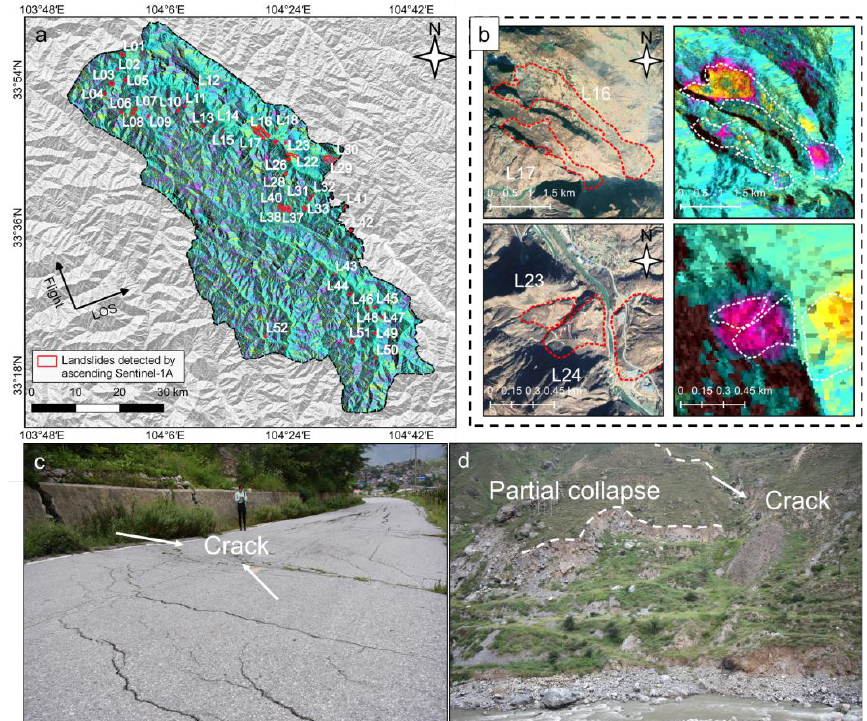
Figure 4. Stacking-InSAR landslide detection results based on ascending data: ( a ) Stacking-InSAR phase results; ( b ) typical landslides; ( c ) distribution of cracks on the leading edge of the L16 landslide; and ( d ) the L24 landslide spatial collapse and crack.